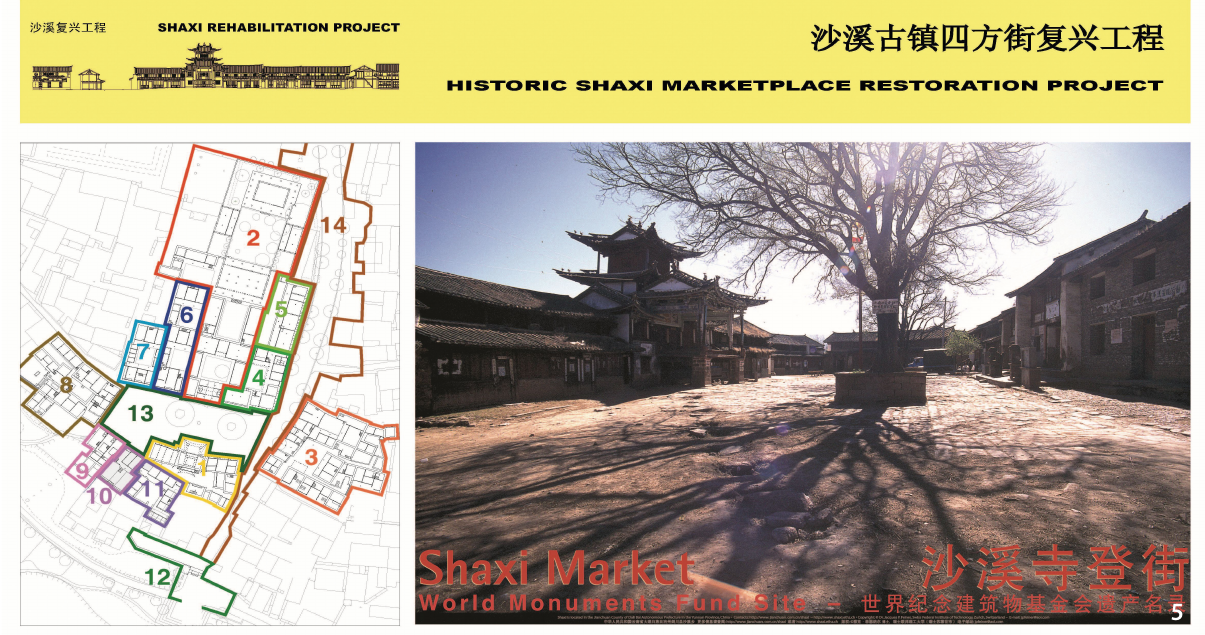
Figure 5 Historic Shaxi Marketplace restoration project and its present condition (Source: the